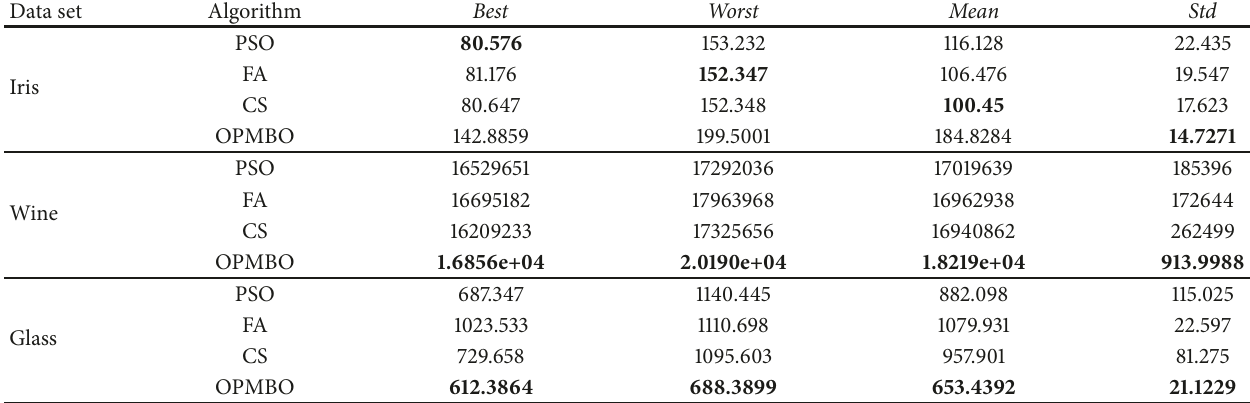
Table 11: The comparison of the clustering optimizations on the four different optimization